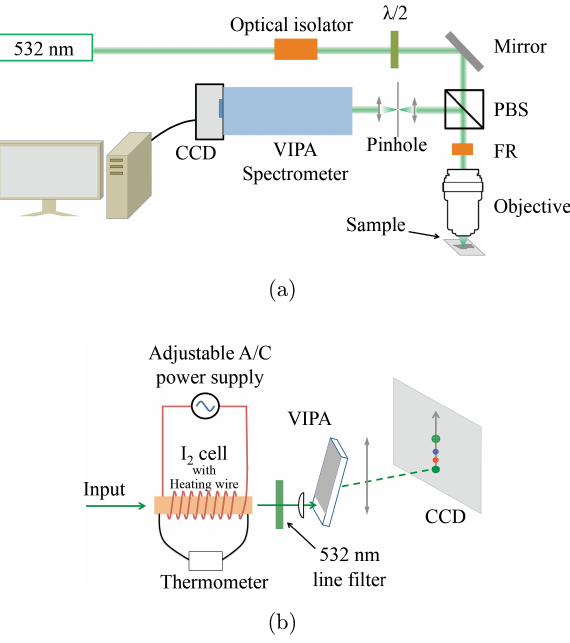
Fig. 1. (a) Schematics of the experimental setup. PBS: Po- larizing beam splitter, FR: Faraday rotator, VIPA: Virtually imaged phased array; (b) A more detailed illustration for the VIPA